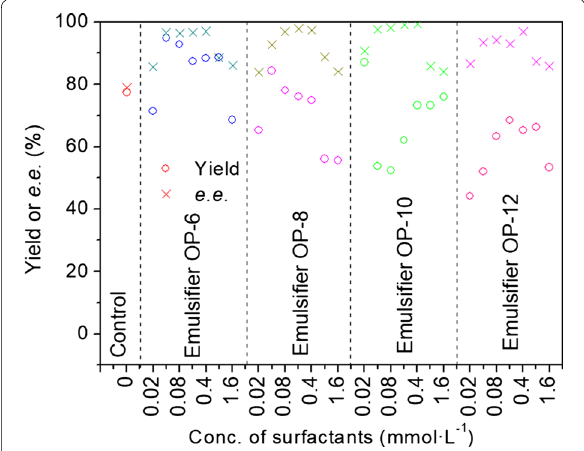
Fig. 2 Effect of Emulsifier OP surfactants on asymmetric reduction of 2-octanone by baker’s yeast cells. Reaction condition: 10 mmol L −